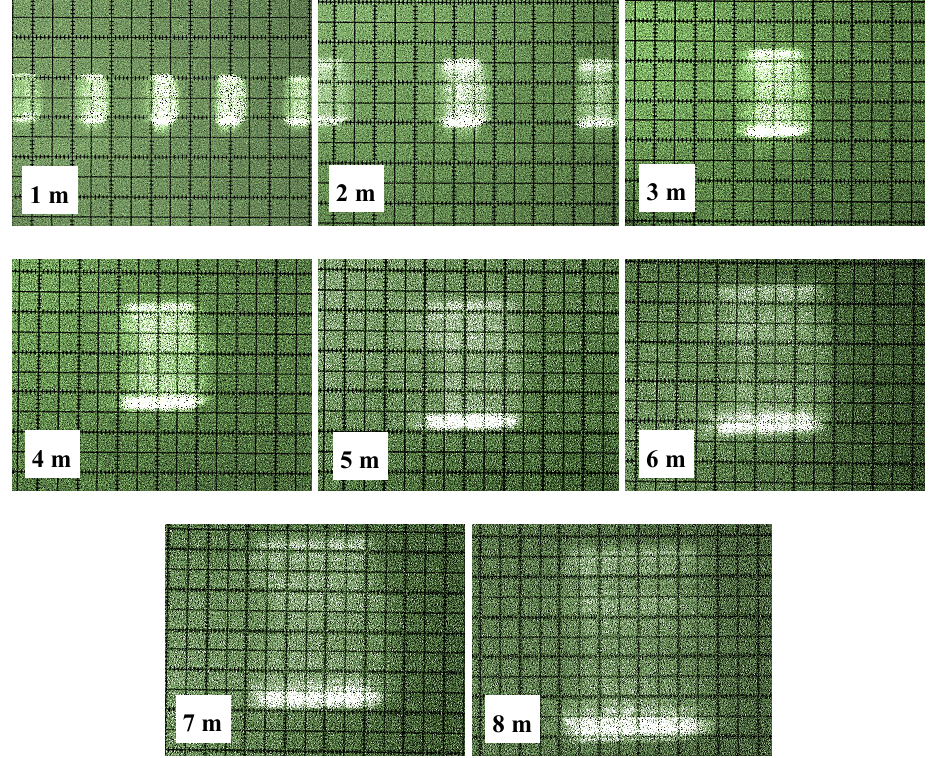
Figure 10. Photographs of the laser beam cross-section at distances of between 1 and 8 m from the sensor. The dimensions are shown in Table 1. The smallest subdivisions were 1